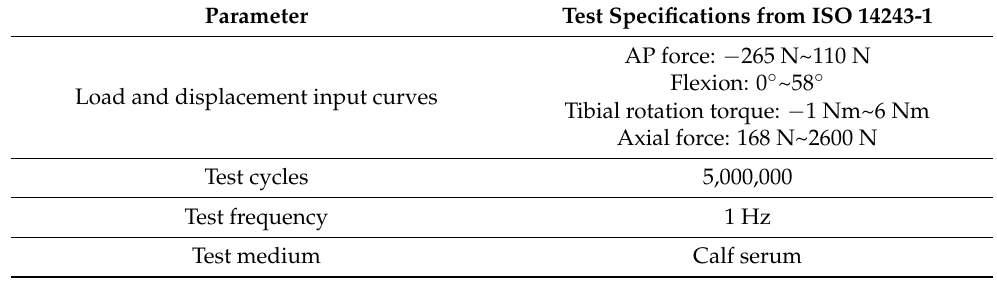
Table 2. Wear test parameters.